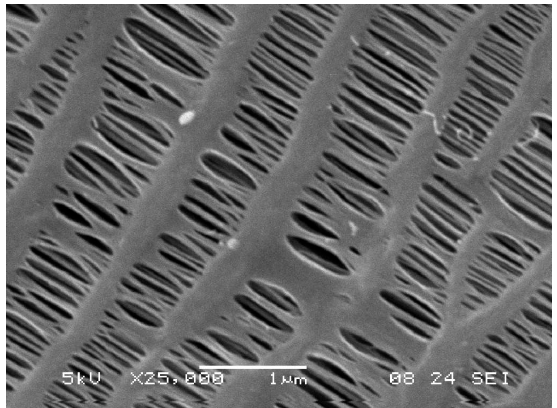
Figure 1. An electron microscope image of the porous polypropylene membrane that was used for distillation; the photograph was provided by ZENA s.r.o. [27].